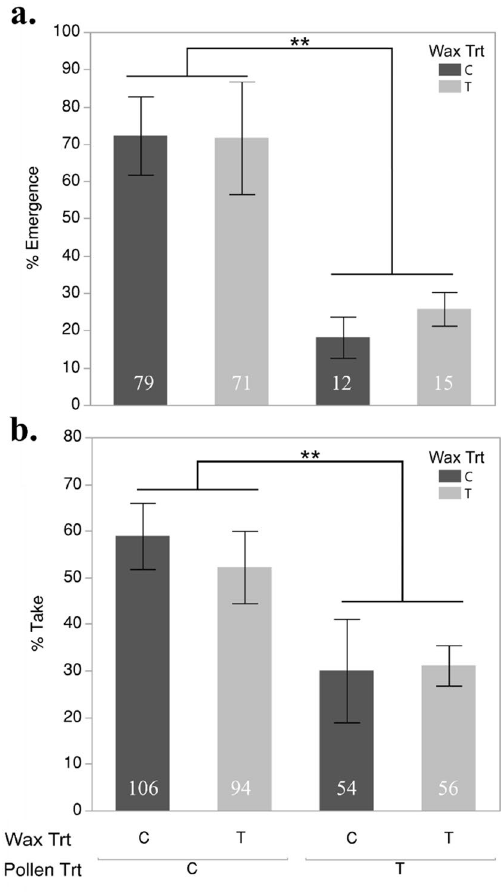
Figure 2. Emergence survival ( a ) and percent cell construction (% Take) ( b ) for queens reared in wax and pollen treatment (T) and control (C) environments ** P < 0.0001. Sample sizes for each respective treatment are shown inside each bar. Error bars represent the standard